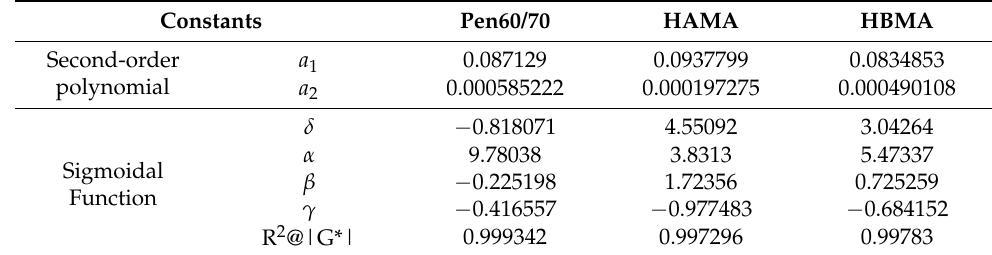
Table 3. Regression constants of the second-order polynomial and sigmoidal